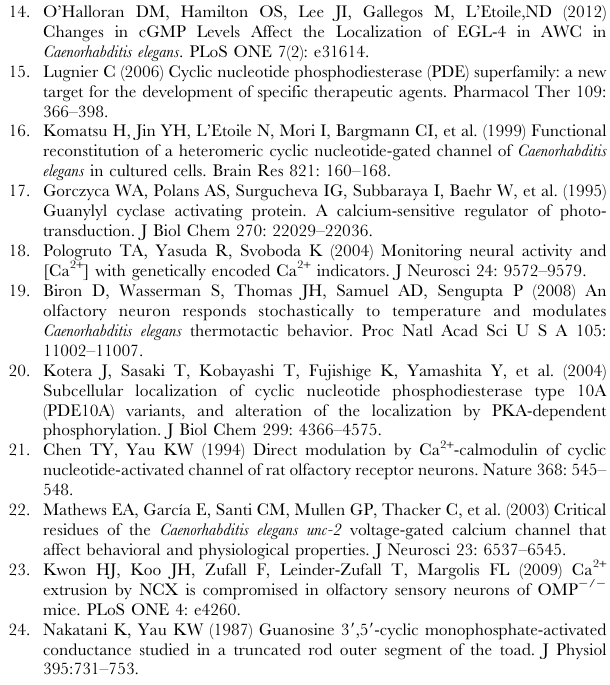
Figure S4 Changes in [Ca 2 + ], G-CaMP fluorescence and membrane potential. The bars indicate periods of stimulation.